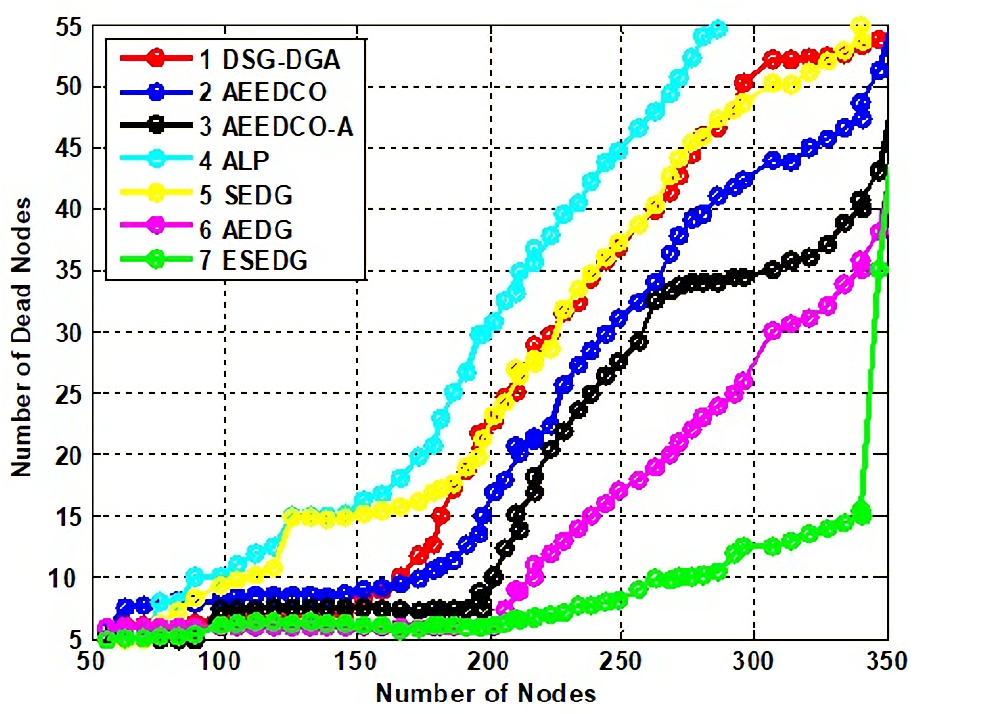
Figure 10. Analysis of network dead nodes with baseline schemes.